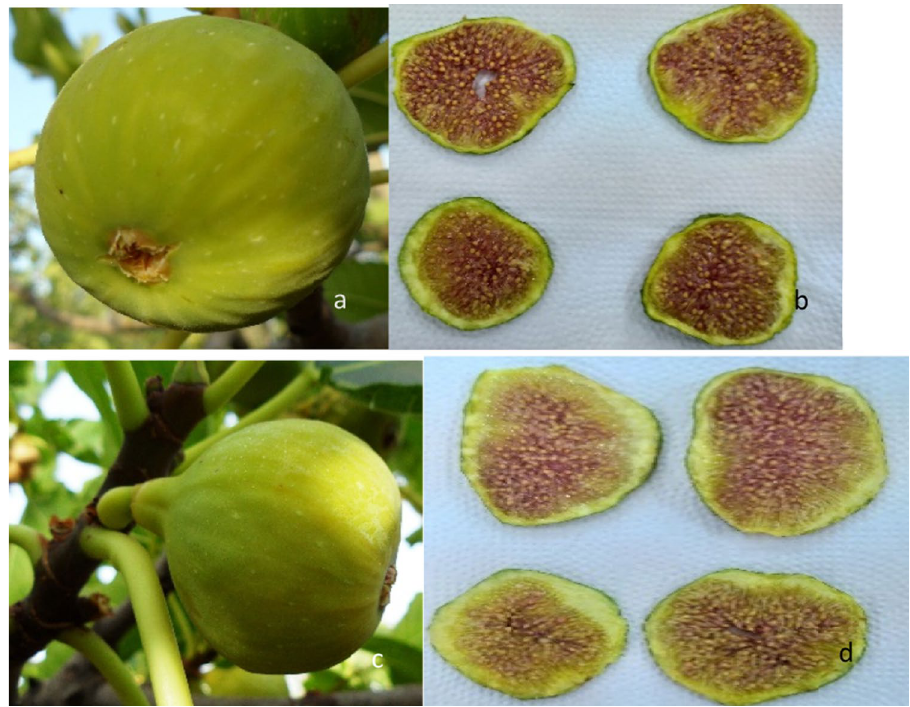
Figure 6. Pictures of the whole fruits and their dried slices at 80 °C and 300 m 3 /h. ( a – d ) refer to ‘Conidria’ and ‘Rey Blanche’, respectively.